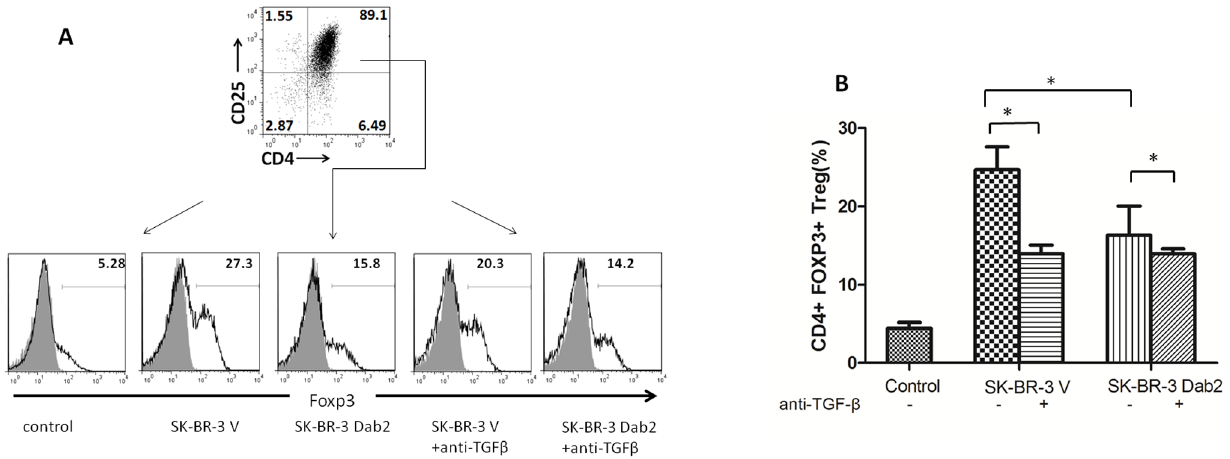
Figure 6 Differentiation of CD4 + CD25- naı¨ve T cells from peripheral blood of healthy subjects. (A) CD4 + CD25- naı¨ve T cells treated with negative control medium, condition medium from SK-BR-3 V cells (4 h), and condition medium from SK-BR-Dab2 cells (4 h). Cells were treated in the presence or absence of TGF- b antibody, harvested 96 h later, and analyzed by flow cytometry for CD4 + CD25 + Foxp3 + Tregs. Representative data from one determination are shown. (B) Proportion of CD4 + CD25 + Foxp3 + Tregs formed in different groups. Data are means 6 SD of three independent experiment (*P , 0.05).